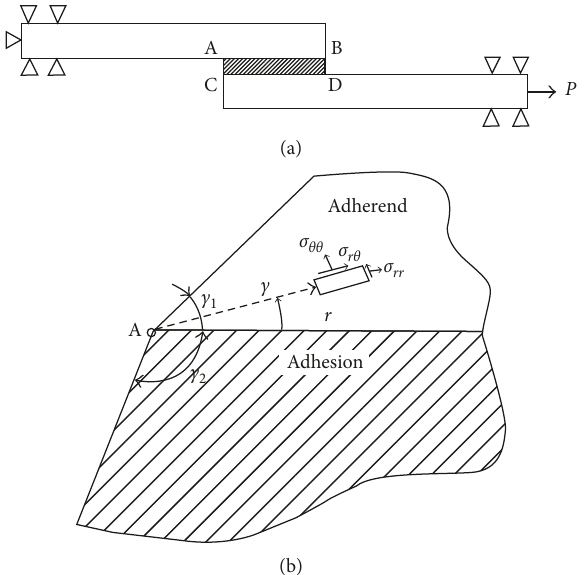
Figure 1: Model of bimaterial interface point. (a) Geometry of single-lap joints; (b) model of bimaterial